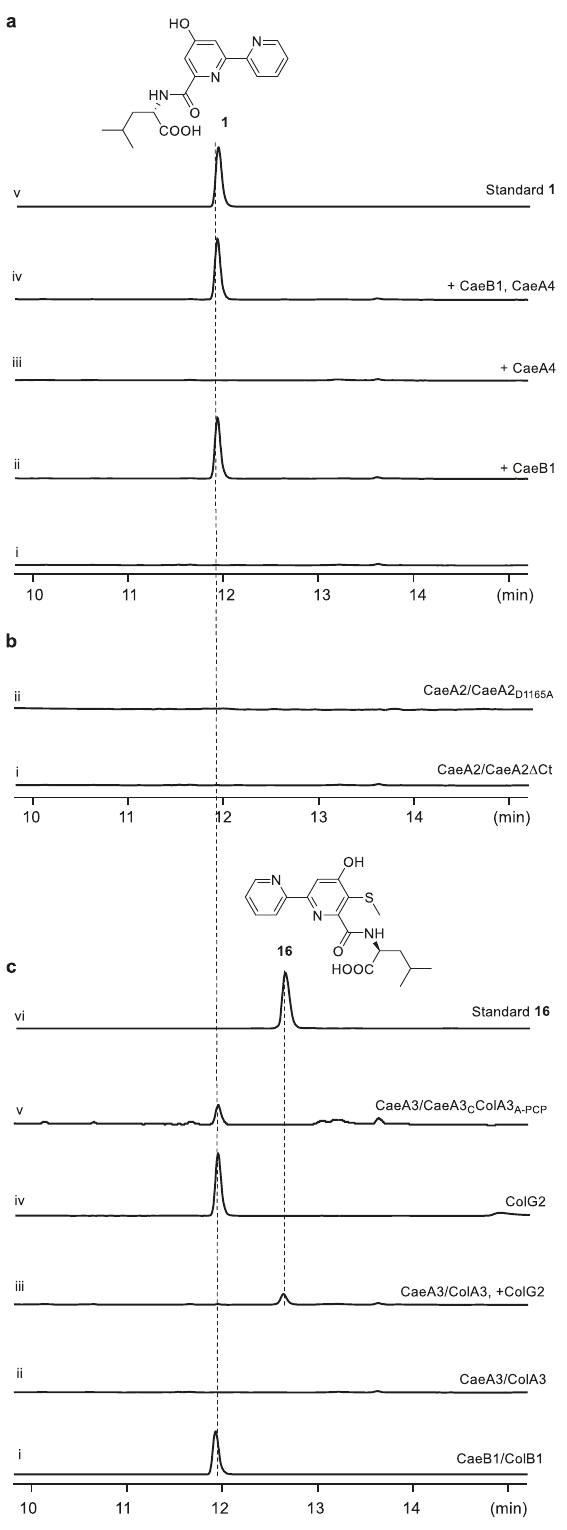
Fig. 2 In vitro reconstitution of the 2,2 ’ -bipyridine assembly line. 2,2 ’ - Bipyridine products were examined by HPLC ( λ 315 nm). Each assay was performed at least three times, and every time at least two parallel samples were used. a Determination of the trans -acting partner. In the reaction mixture where the proteins CaeA1, CaeA2, and CaeA3 were combined with the substrates picolinic acid, malonyl-CoA, L -cysteine, and L -leucine as well as ATP (i), CaeB1 (ii), CaeA4 (iii), or both CaeB1, and CaeA4 (iv) were added individually. Synthetic 1 was used as a standard (v). b Validation